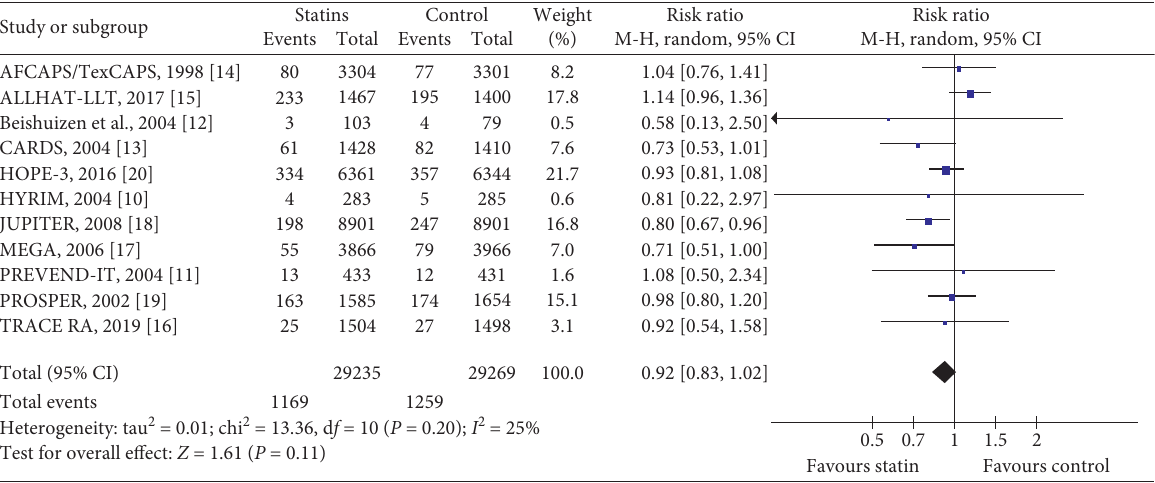
Figure 6: The occurrence of all-cause mortality in the included